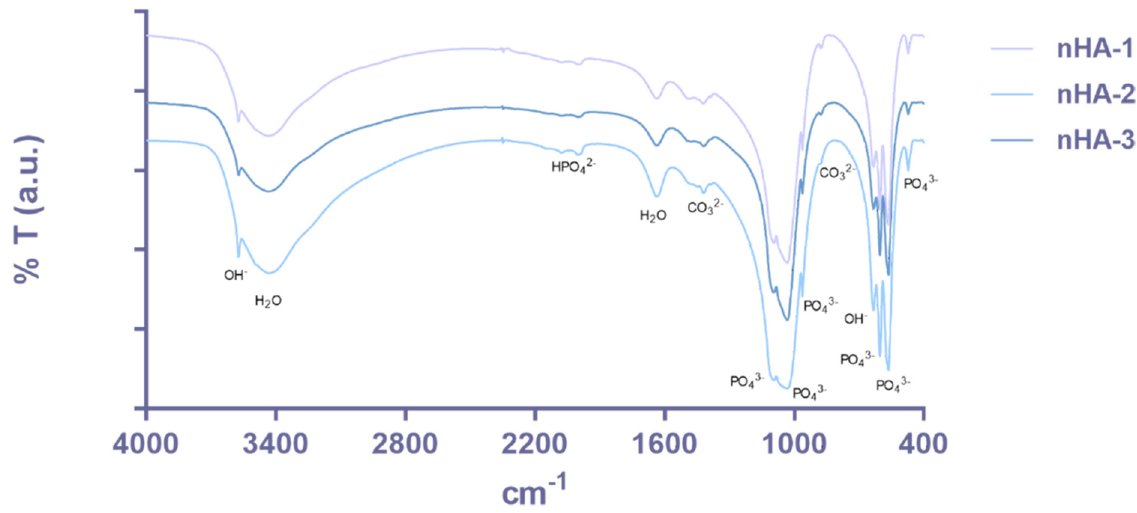
Figure 4. FTIR spectra for nHA-1, -2 and -3 samples.